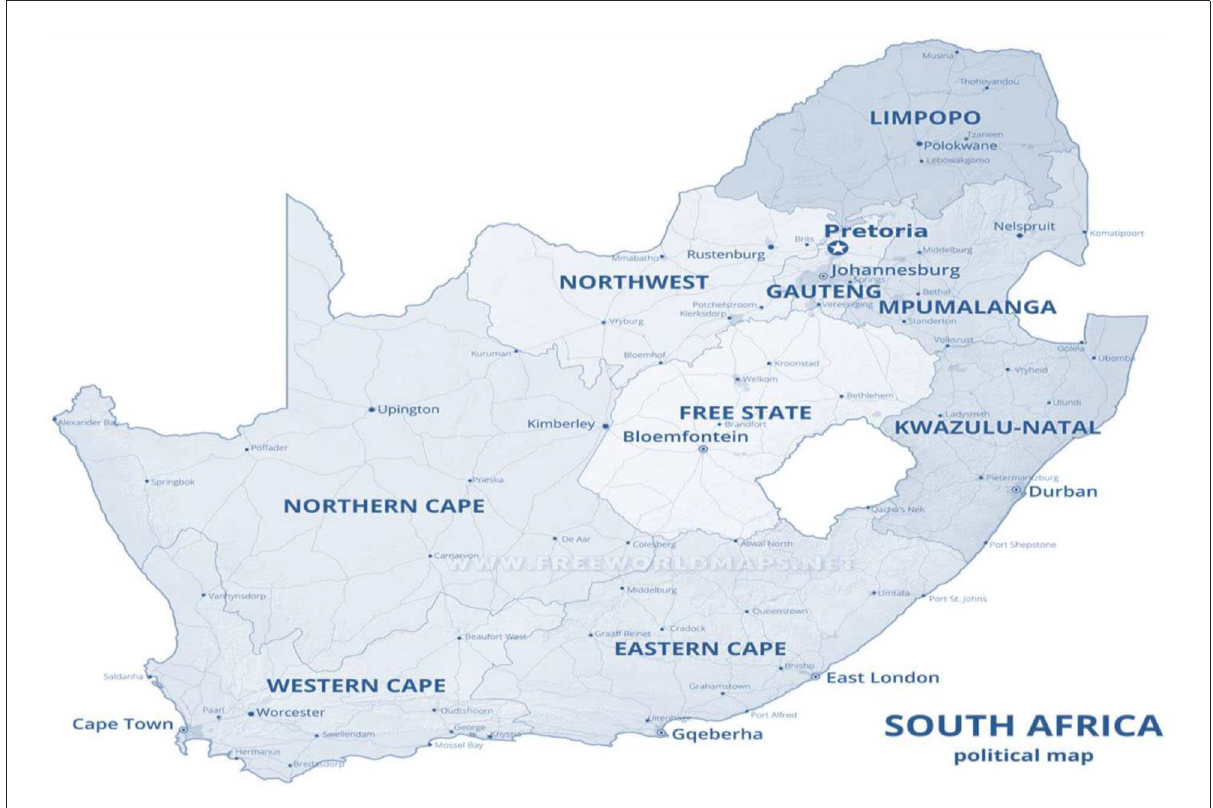
FIGURE3 Map of South Africa showing the nine provinces (Bundy et al.,